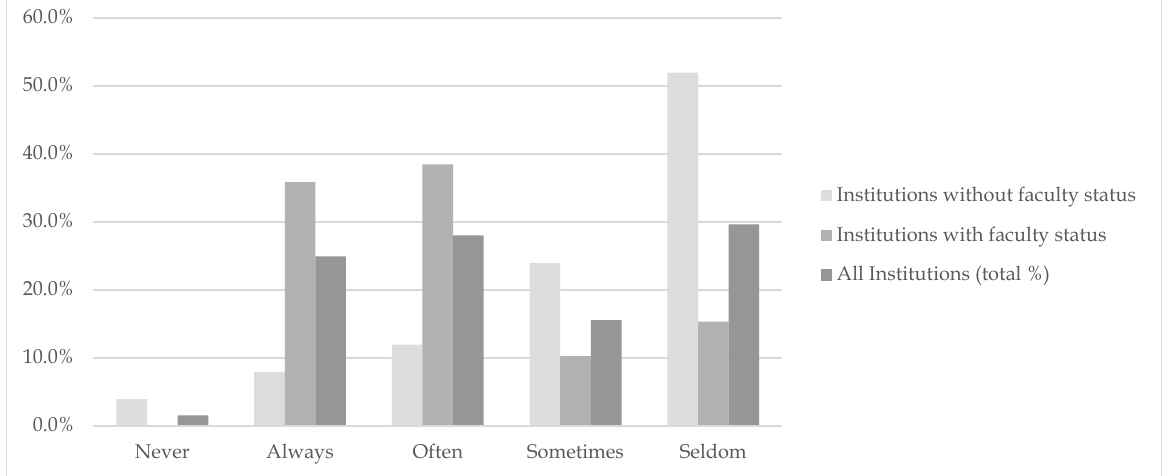
of “always” and “often” responses were reported by not hold faculty status (Figure